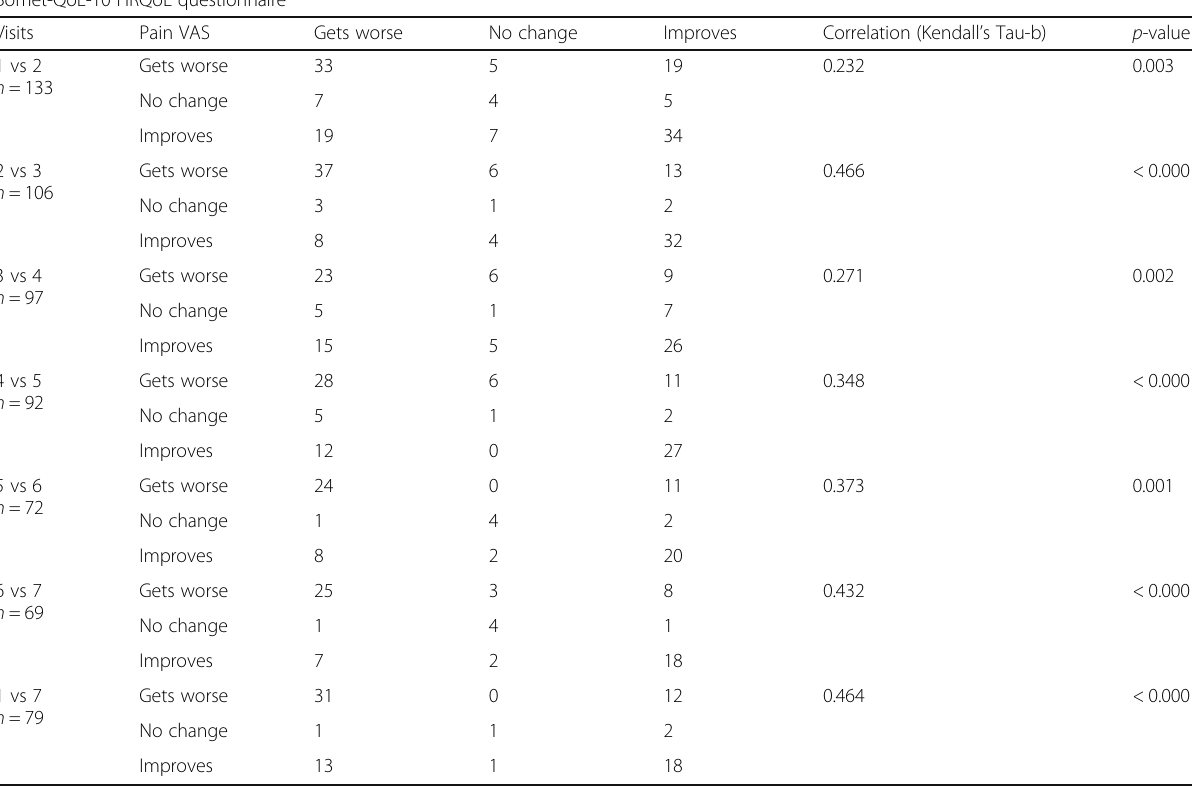
Table 2 Relationship between HRQoL according to BOMET-QoL-10 and pain VAS Bomet-QoL-10 HRQoL